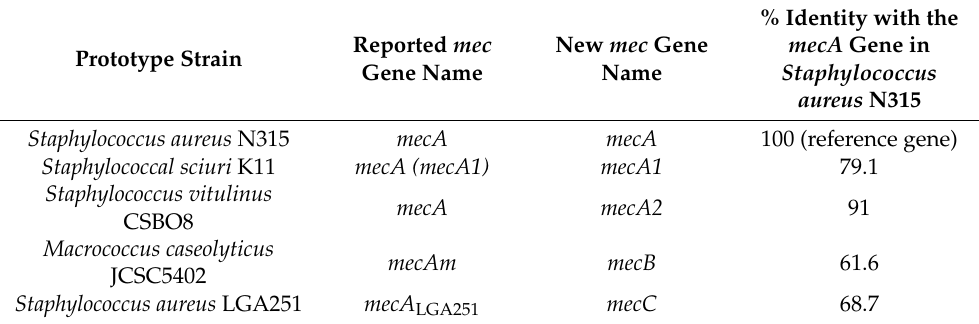
Table 1. List of mecA homologs shown in the IWG-SCC guidelines. Adapted with permission from Ref. [18]. 2012, American Society for